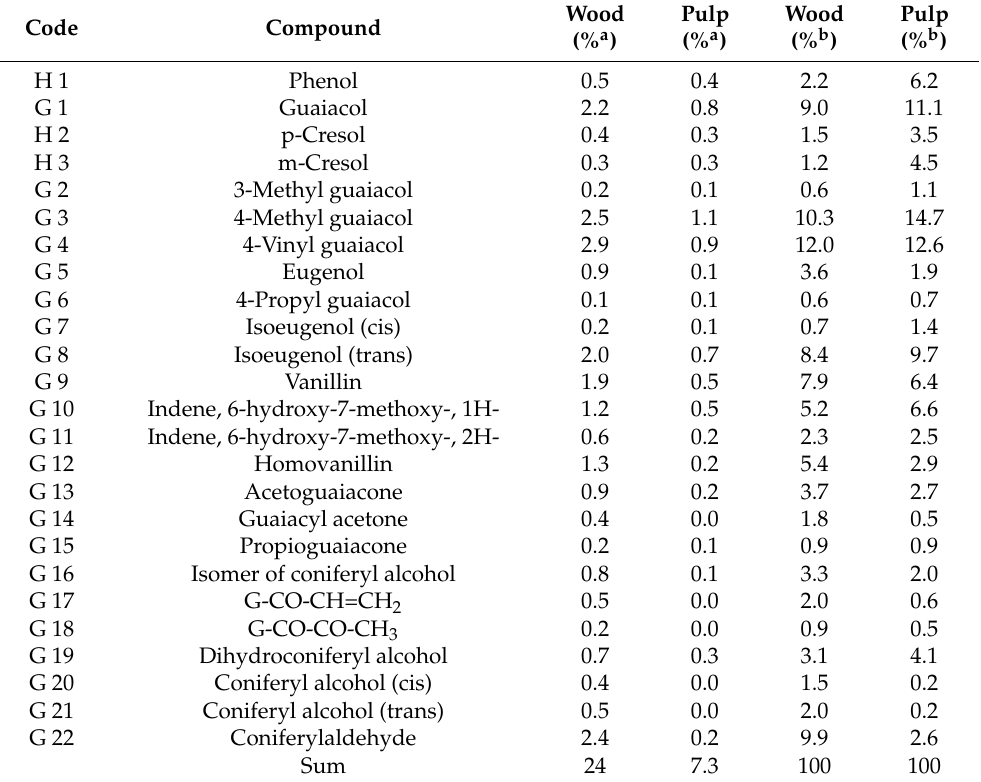
Table 1. Distribution of lignin pyrolysis products of maritime pine wood (adapted from [7] and Kraft pulps based on all pyrolysis products (a) and based on lignin products alone (b) (100%). Code